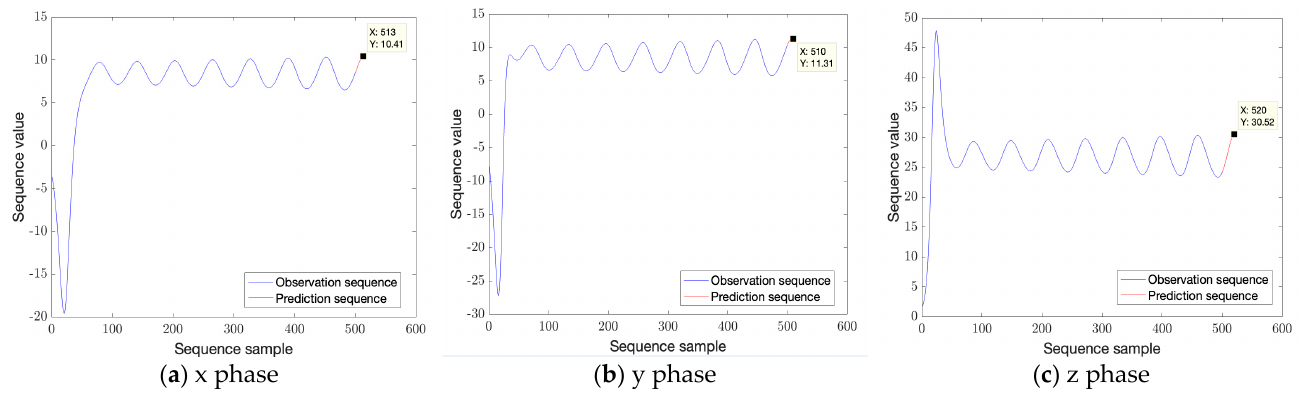
Figure 5. Lorenz chaotic time series prediction results.